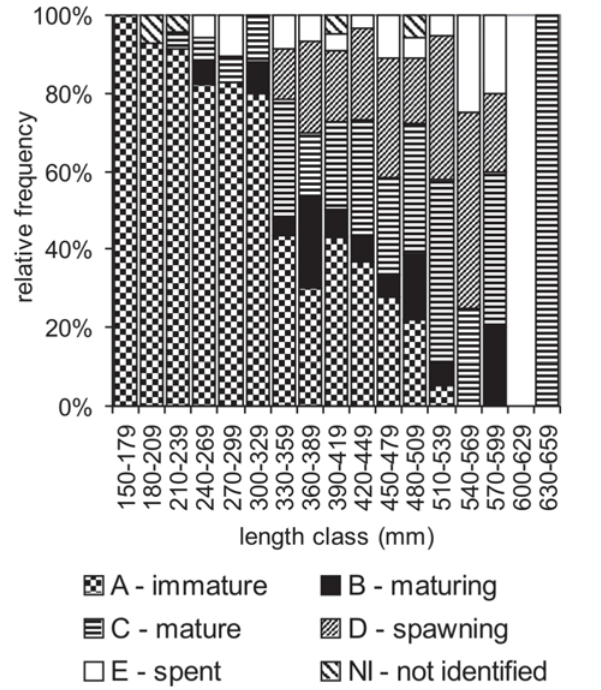
Fig. 10. Merluccius hubbsi : relative frequency of females by stage of gonadal maturation identified microscopically by class of total lenght (n = 326).